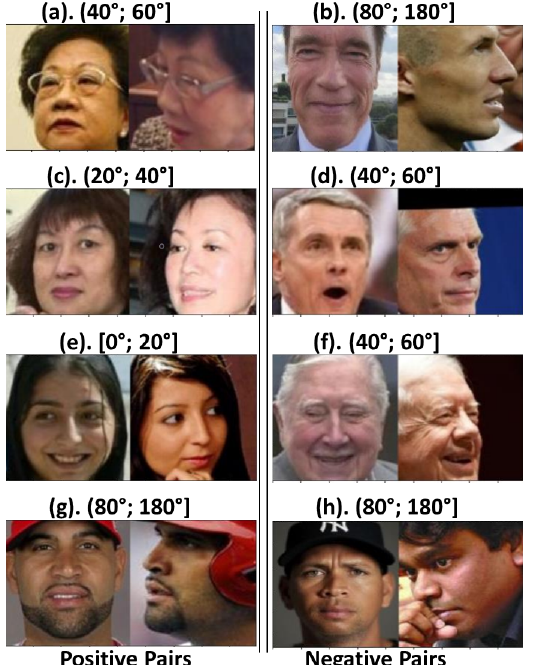
Figure 10. Example of evaluation subset pairs incorrectly classified by MobileFaceNet.